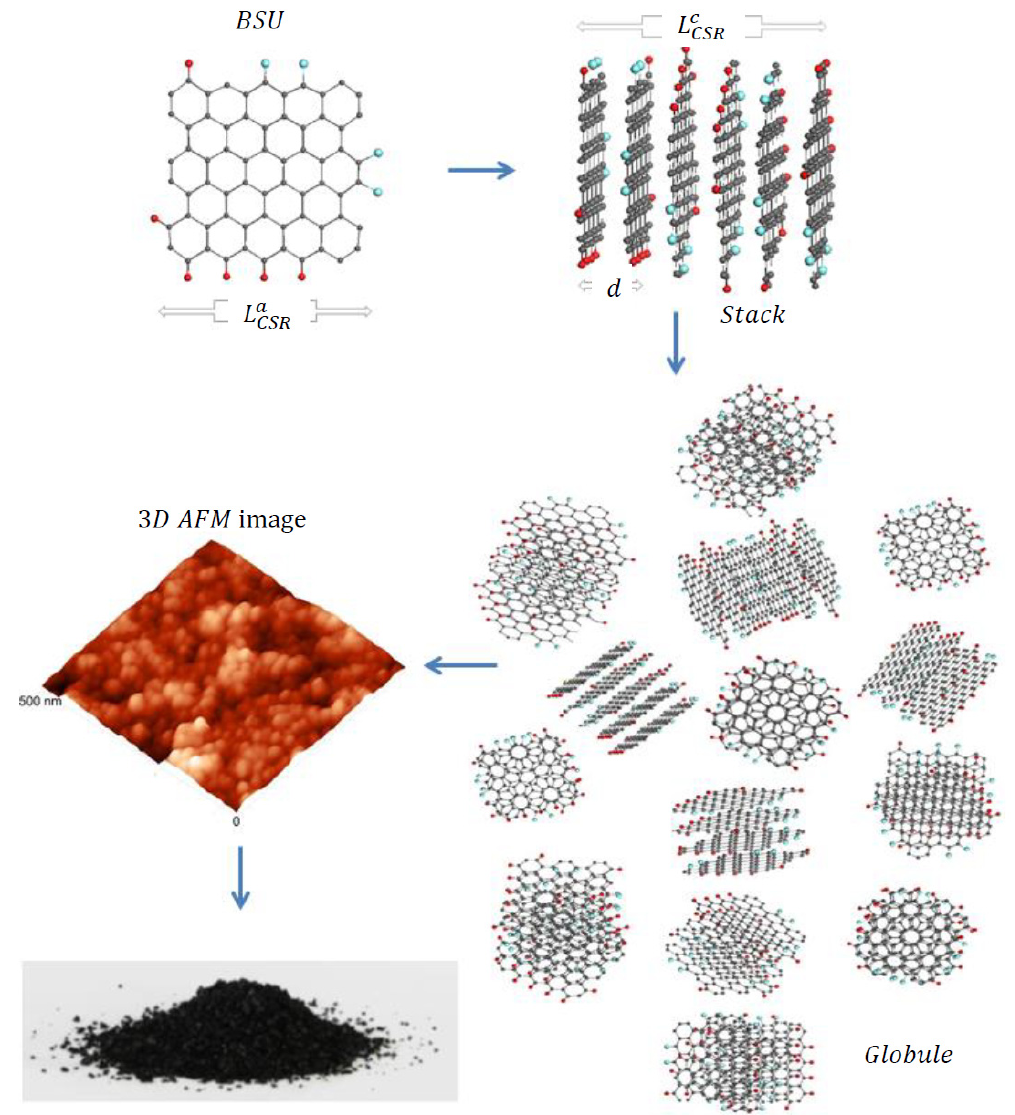
Figure 1. Schematic transformation from a single basic structure units (BSU) molecule (one of the BSU models C 66 O 4 H 6 for shungite carbon [18]) to powdered solid amorphous carbon via BSU stacks and globule(s). The stacks consist of 4 to 7 BSU layers, di ff erently oriented to each other. Planar view on a model globule composed of di ff erent stacks, with total linear dimensions of ~6 nm. Dark gray, red and blue balls depict carbon, hydrogen, and oxygen atoms, respectively. Three-dimensional atom-force microscope (AFM) image of globular structure of shungite carbon obtained with atomic force microscope NTEGRA Prima (NT-MDT, Zelenograd, Russia). The size distribution of the observed nanoscale particles peaked at 25 nm.